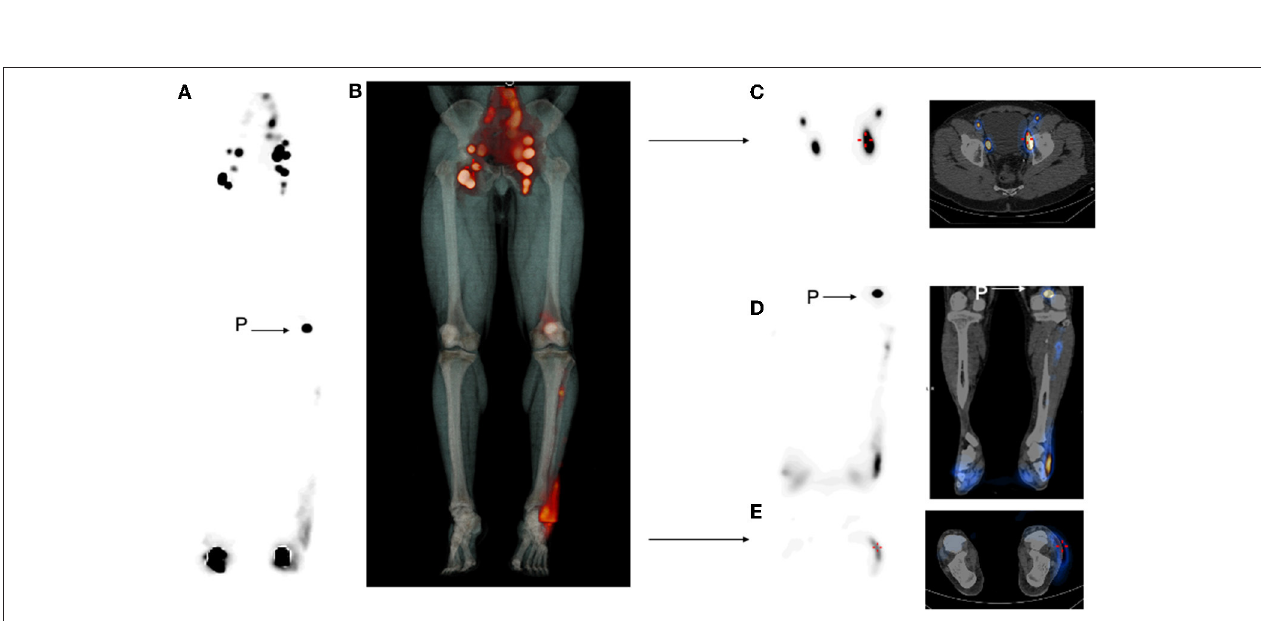
Frontiers in Medicine |